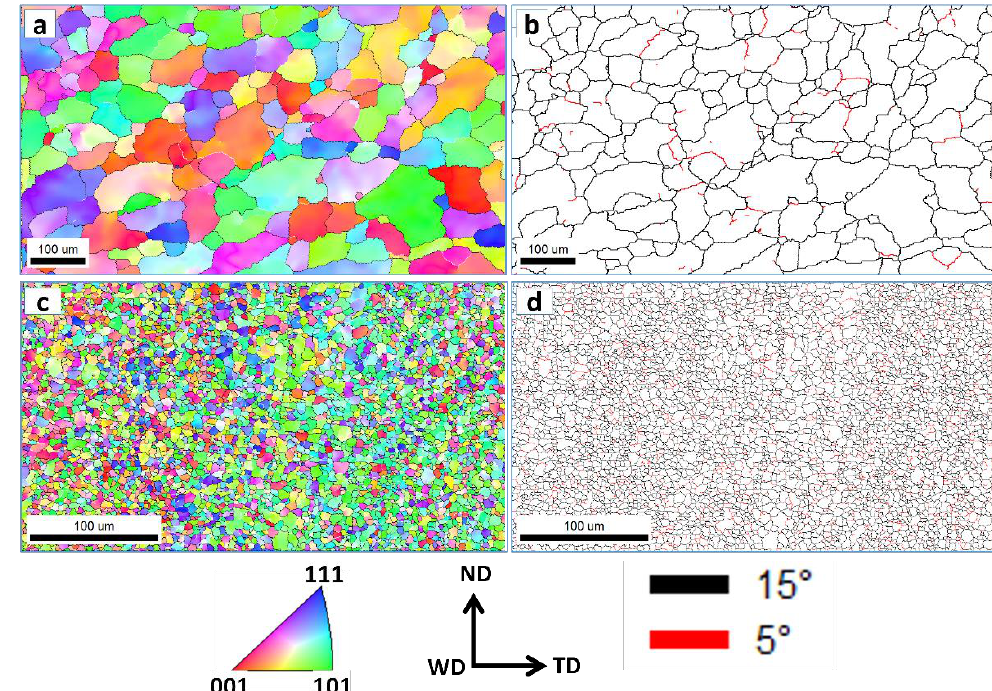
Figure 16. IPF maps and grain boundary maps of the AA5052-H32 BM ( a , b ) and the SZ after FSSW at 2 s and 500 rpm ( c , d ). The legend for IPF coloring is shown on the map, as well as the grain boundary legend.